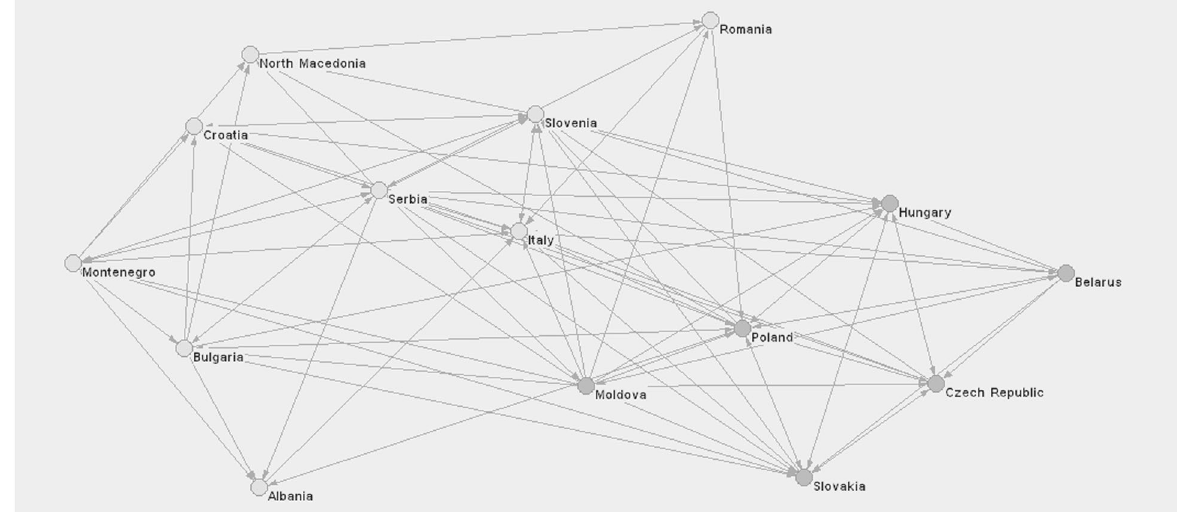
Fig. 2 Preferred partners in future networks of international scienti fi c cooperation among CEI Member States. Two subgroups of countries with denser in-group ties are detected. The two subgroups are represented by dots of lighter and darker grey,